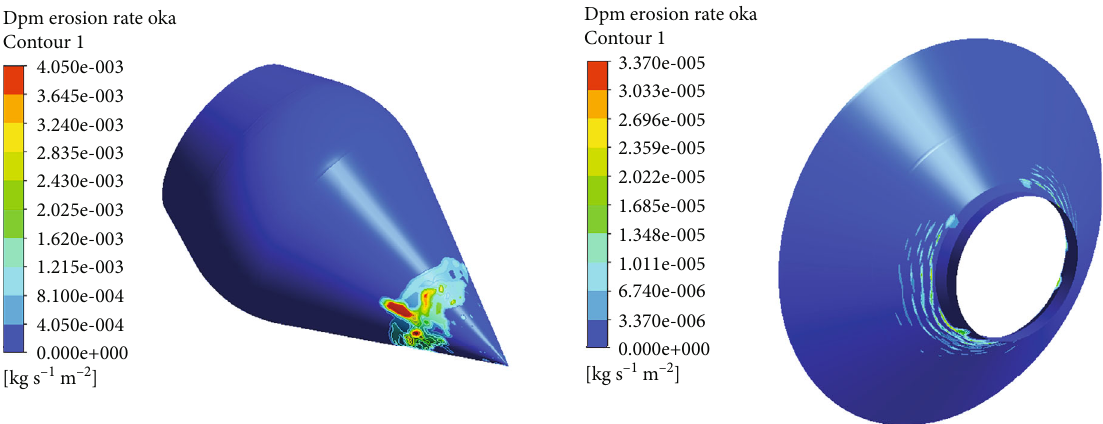
Figure 16: Erosion as predicted from CFD.